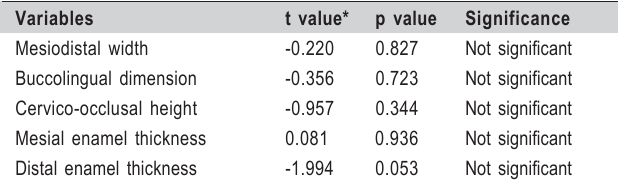
Table 2 - Comparative analysis of the measurements obtained for right (n = 20) and left (n = 20) maxillary first premolars.